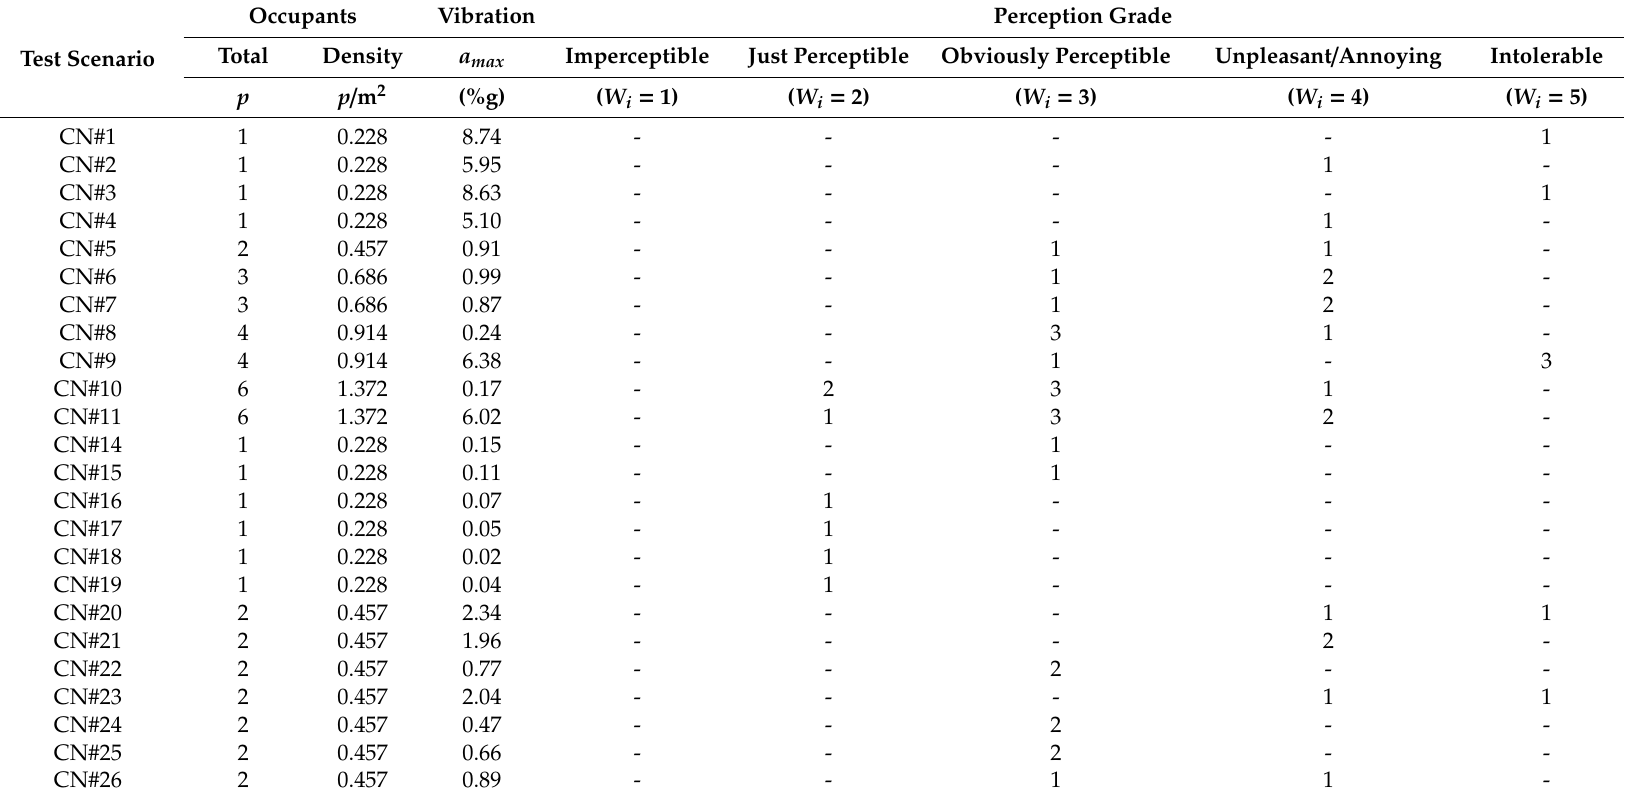
Table 5. Perception grade records for the test CN# n